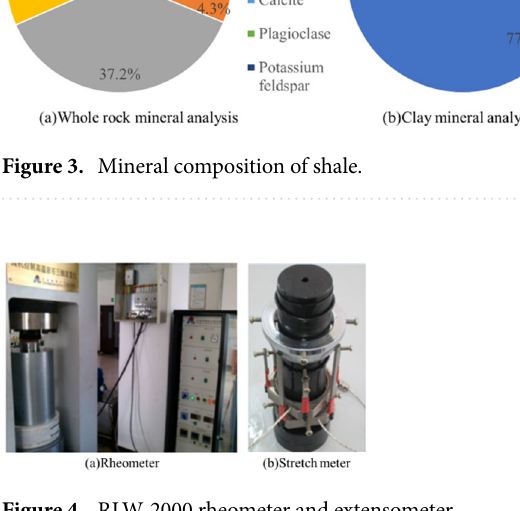
Figure 4. RLW-2000 rheometer and